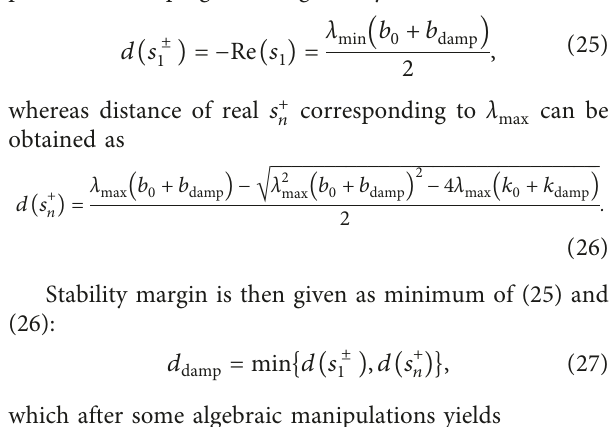
Figure 2: Stability margin dependence on damping